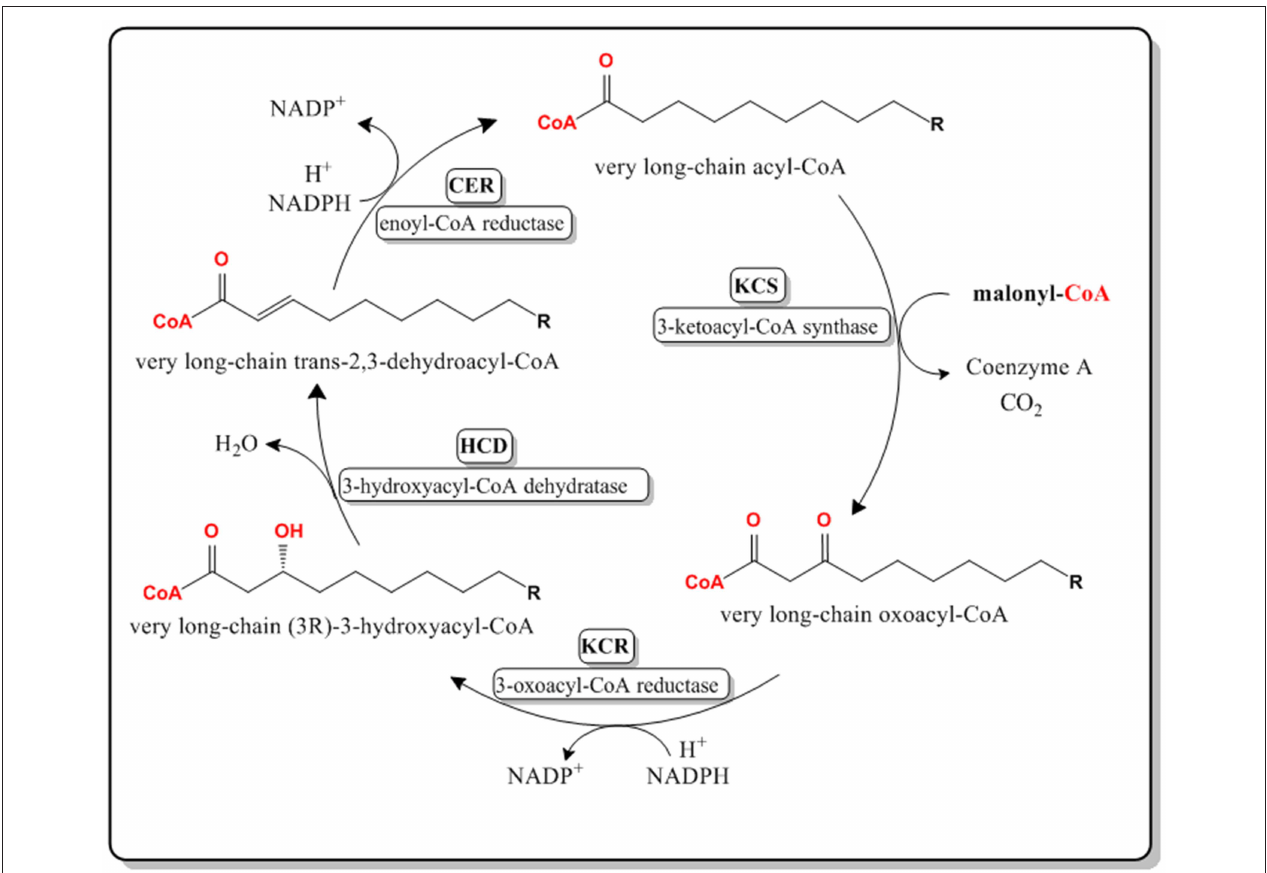
FIGURE 1 | Pathway for the biosynthesis of VLCFAs in the endoplasmic reticulum of Arabidopsis thaliana cells. Malonyl-CoA is used as the 2-Carbon elongation unit. Very long chain refers to a chain length of 20 carbon atoms or